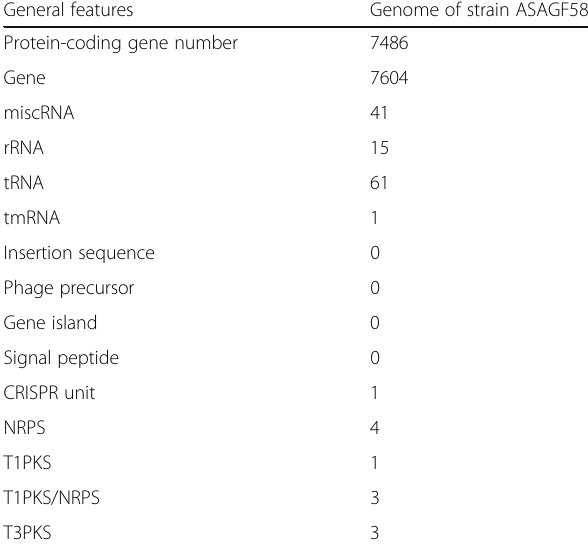
Table 1 Genome features of strain